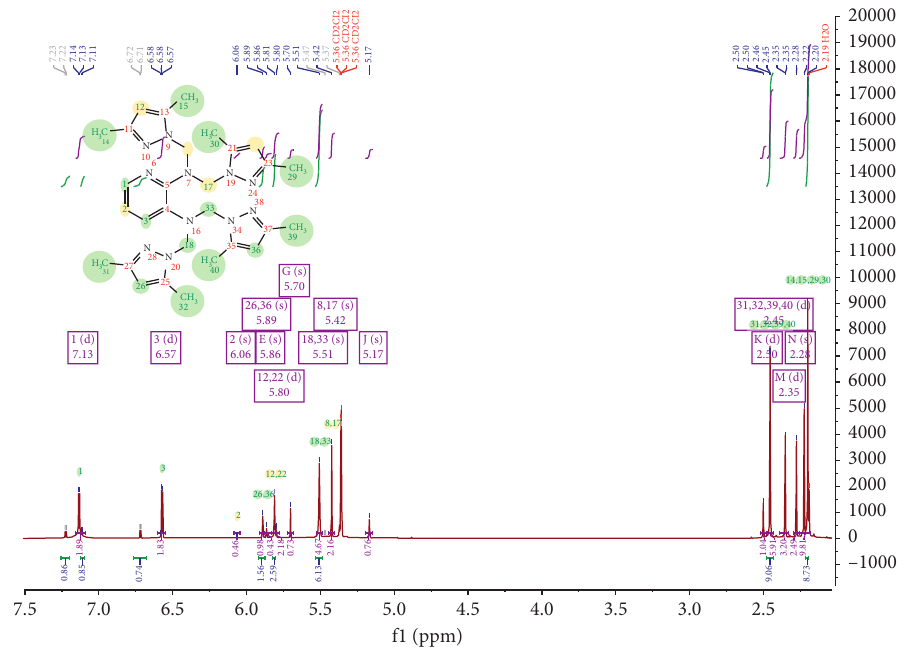
Figure 3: 1 H NMR spectrum of N 2 ,N 2 ,N 3 ,N 3 -tetrakis((3,5-dimethyl-1H-pyrazol-1-yl) methyl)pyridine-2,3-diamine ( 13